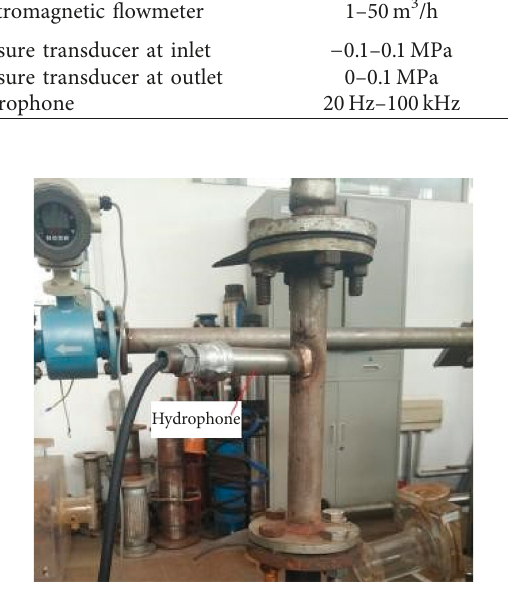
Figure 3: Positions for flow-borne noise measurement.